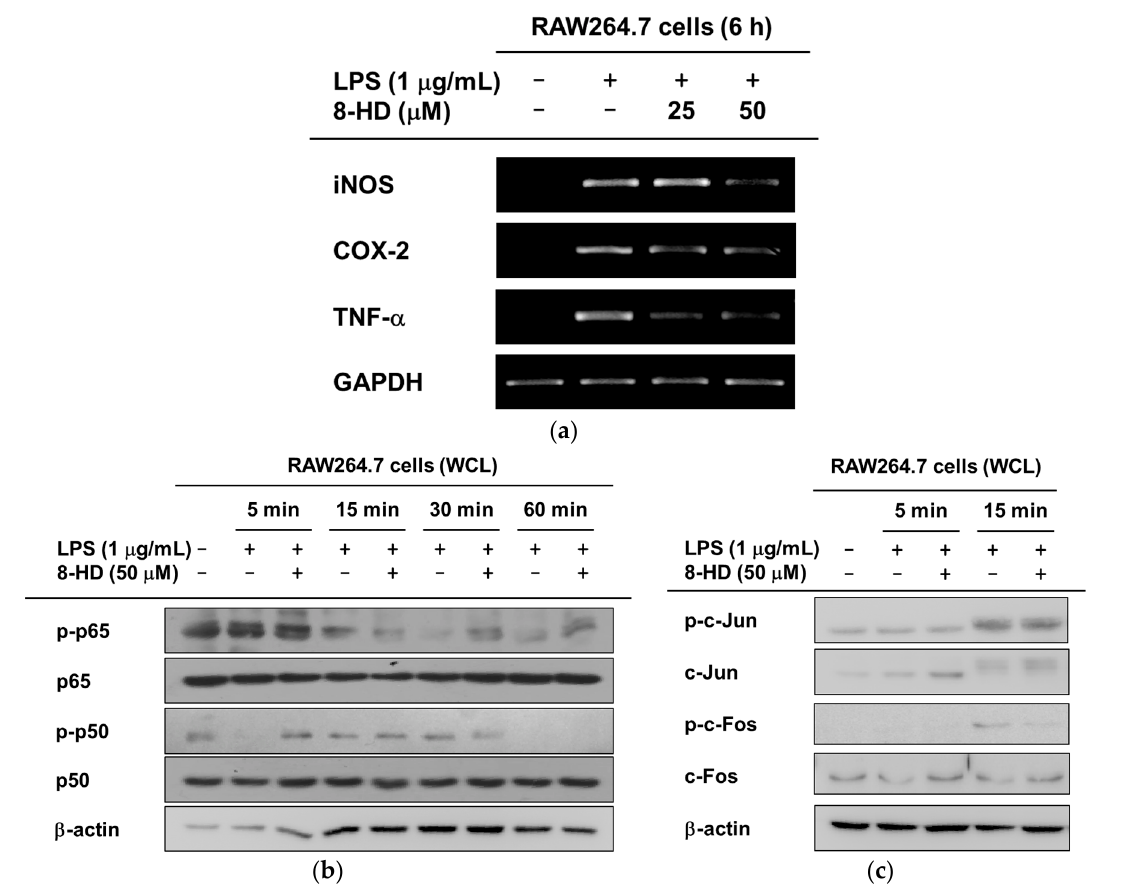
Figure 4. The regulatory mechanism of 8-HD at the transcriptional level. ( a ) The mRNA expression levels of inflammatory molecules were analyzed by semi-quantitative PCR. RAW264.7 cells were pre-treated with 8-HD for 30 min, and LPS was added for 6 h. mRNA was isolated, and RT-PCR was conducted. ( b , c ) RAW264.7 cells treated with 8-HD and/or LPS were analyzed in a time-dependent manner (0–60 min). The phosphorylation levels of p65, p50, c-Jun, and c-Fos were determined by immunoblotting. β -actin was detected as a loading control.